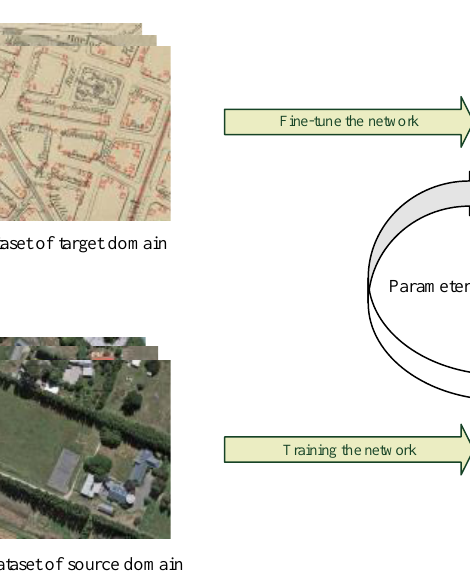
Figure 6. Integration of DOANet with transfer learning.